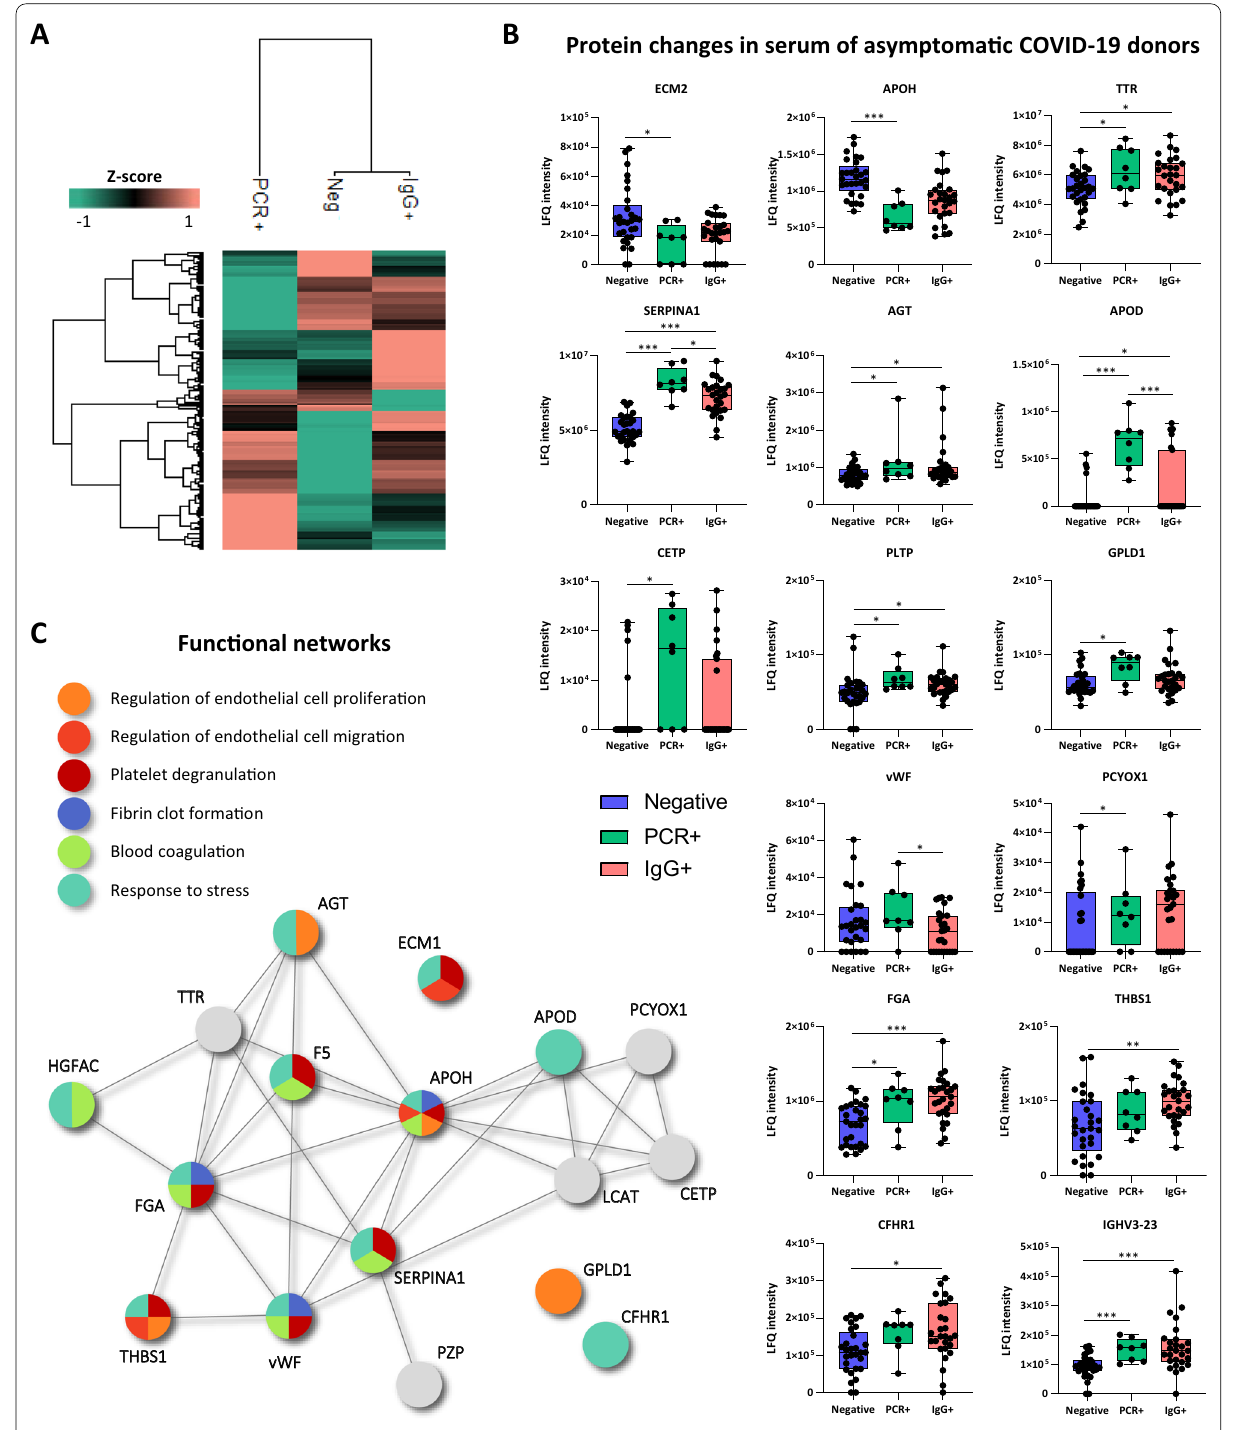
Fig. 2 Proteins altered in asymptomatic patients’ serum and functional network. A Hierarchical clustering comparing the proteins patterns of the three groups analyzed. B Graphical representation of the label‑free quantification (LFQ) intensities registered for proteins altered in the serum of COVID‑19 PCR (n:8) and COVID‑19 IgG asymptomatic patients (n:27) compared to COVID‑19 negative donors (n:29). Differences were + + considered significant when p‑values < 0.05. *p‑value < 0.05, *p‑value < 0.01, *p‑value < 0.001. C Functional network, obtained with String on‑line platform, highlighting the interactions detected between the serum proteins altered in the groups analyzed. Some of the most relevant functions identified for these proteins are